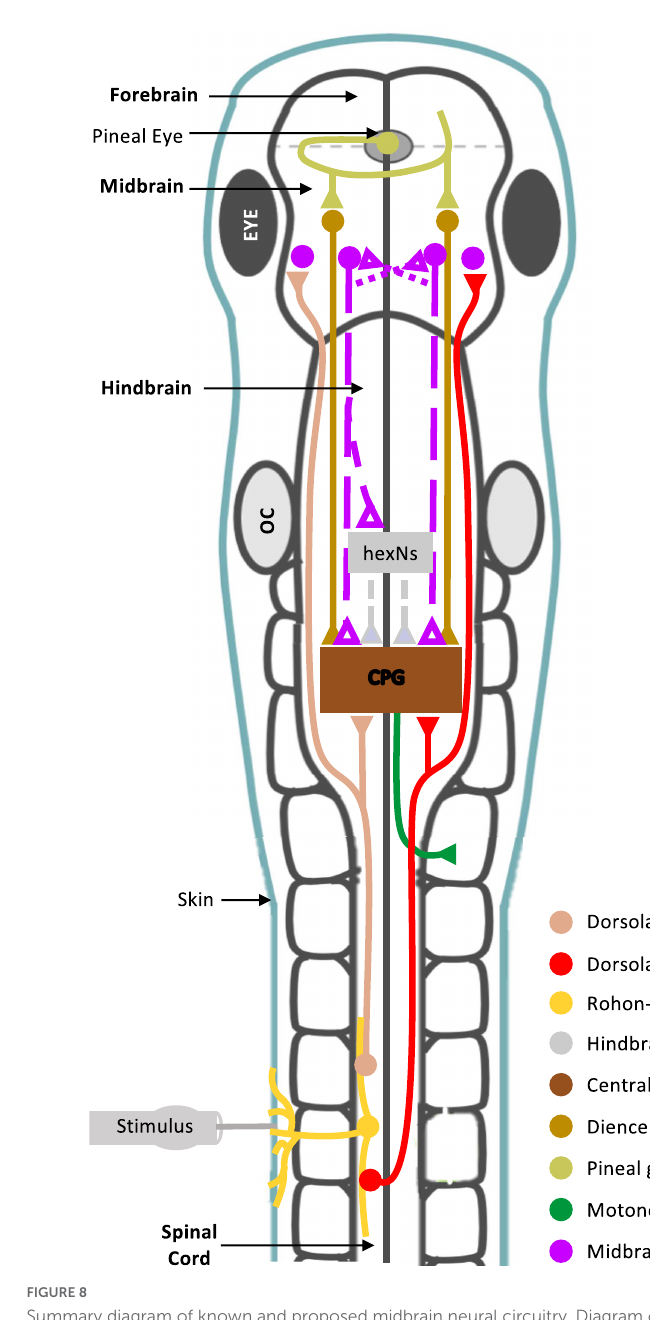
FIGURE8 Summary diagram of known and proposed midbrain neural circuitry. Diagram of the brain and spinal cord of the Xenopus laevis tadpole at developmental stage 37/38, showing already known and newly proposed neuronal connections involved in the initiation of swimming in response to photic and mechanical stimuli. Mechanosensory Rohon-Beard (RB) neurons innervate the skin of the trunk and tail. The central axons of the RB neurons transmit excitation via sensory interneurons namely dorsolateral commissural (dlc) and dorsolateral ascending (dla) interneurons. Both interneurons project ascending axons to the hindbrain and midbrain. The second sensory pathway presented in this diagram involves the excitation of the pineal eye photoreceptors in response to light dimming. Axons of pineal ganglion cells form synapses on both sides of the midbrain. Midbrain diencephalic/mesencephalic descending (D/MD) neurons are excited by the pineal ganglion cells, and project caudally into the hindbrain and spinal cord where they could excite Central Pattern Generators (CPGs) directly, or via a novel hindbrain population of sensory memory neurons (hindbrain extension neurons; hexNs), which have been proposed to extend the sensory signal between the sensory pathway and reticulospinal neurons of the swimming CPG. The proposed midbrain interneurons (mINs), if different to D/MD neurons, may also project to the opposite side of the midbrain and/or directly or indirectly to hexNs and the CPG. Each neuron type population and colour coding are displayed in the list. Circles represent groups of cell bodies, single lines represent axons, and triangles represent excitatory synapses. Proposed neuronal connections are indicated by dashed